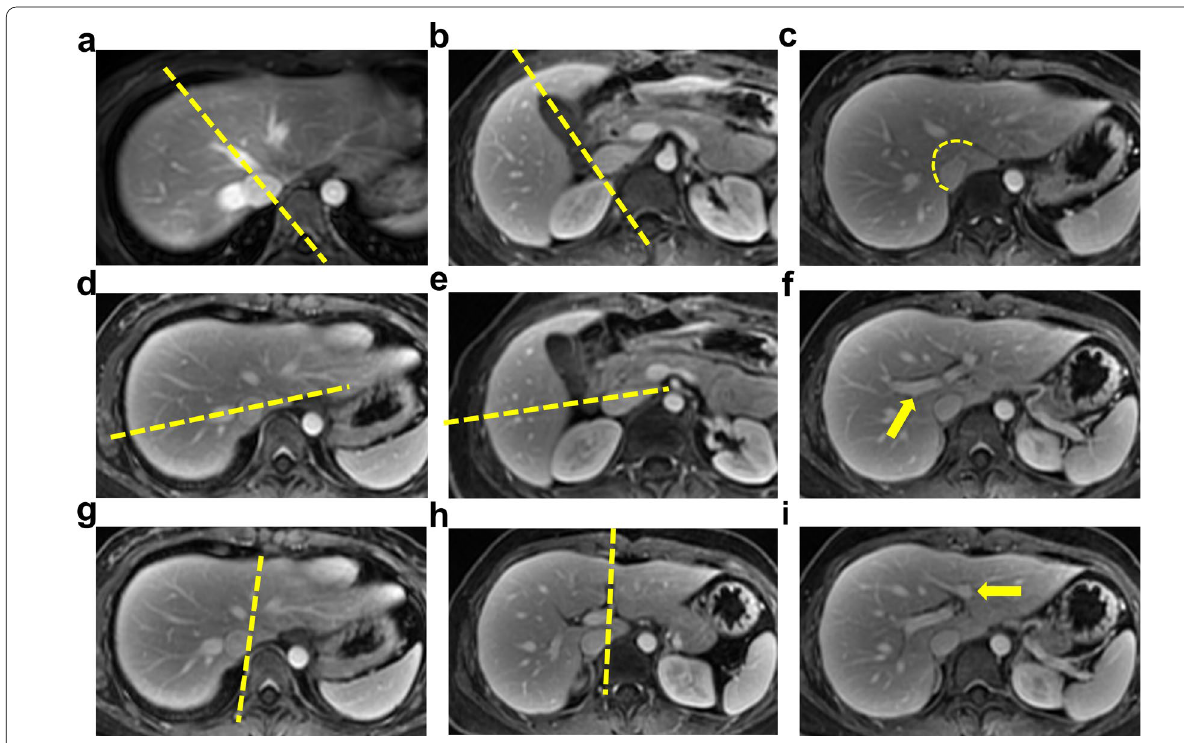
Fig. 1 Method of Couinaud’s classification on axial MRI images. Five planes (three vertical planes along the main stem of hepatic veins and two horizontal planes through the primary branches of the portal vein) are used to divide the liver. In axial MR images, the line from the midpoint of the IVC to the MHV or vertex of the gallbladder fossa divides the right and left lobes ( a and b ). The RHV further divides the right lobe into anterior and posterior segments ( d and e ). The LHV (in the upper part of the liver) and the left longitudinal fissure (in the lower part of the liver) divide the left lobe into a medial and a lateral segment. ( g and h ). Each segment of right and left lateral lobes is further divided into a superior segment and an inferior segment by the main stem of the right portal vein and the sagittal part of the left portal vein ( f and i ). The caudate lobe is separated from the other segments by the natural curve from the venous ligament fissure to the right wall of the IVC ( c ). IVC, inferior vena cava; MHV, middle hepatic vein; RHV, right hepatic vein; LHV, left hepatic